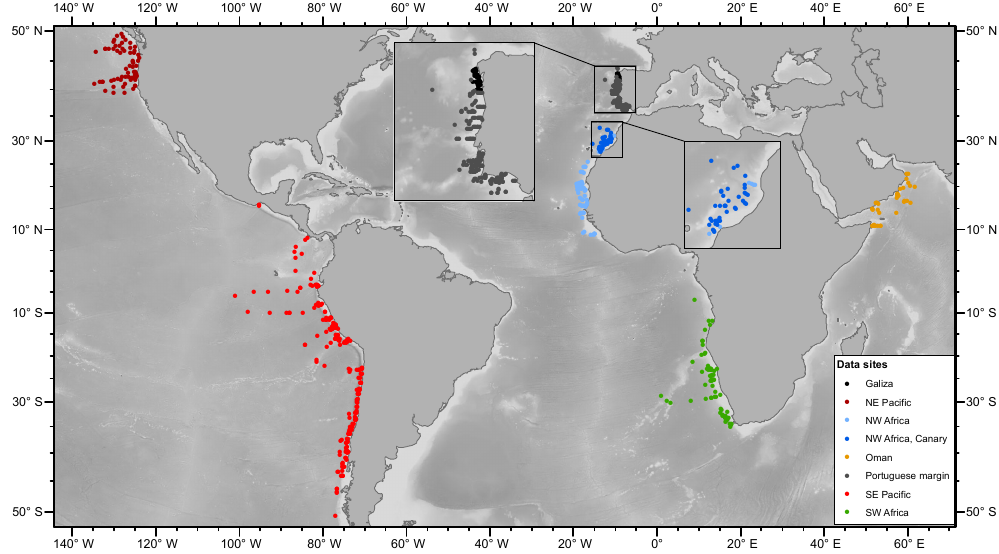
Figure 1. Geographic distribution of the total data set sites considered in this study. Map in WGS84 and Mercator projection. Different colors represented different upwelling